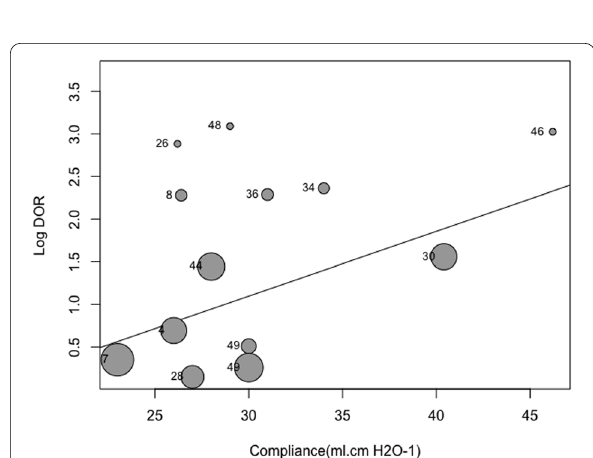
Fig. 5 Bubble plot for meta‑regression of pulse pressure variation with lung compliance pulmonary as a continuous covariate. The number of the point is the reference number of each